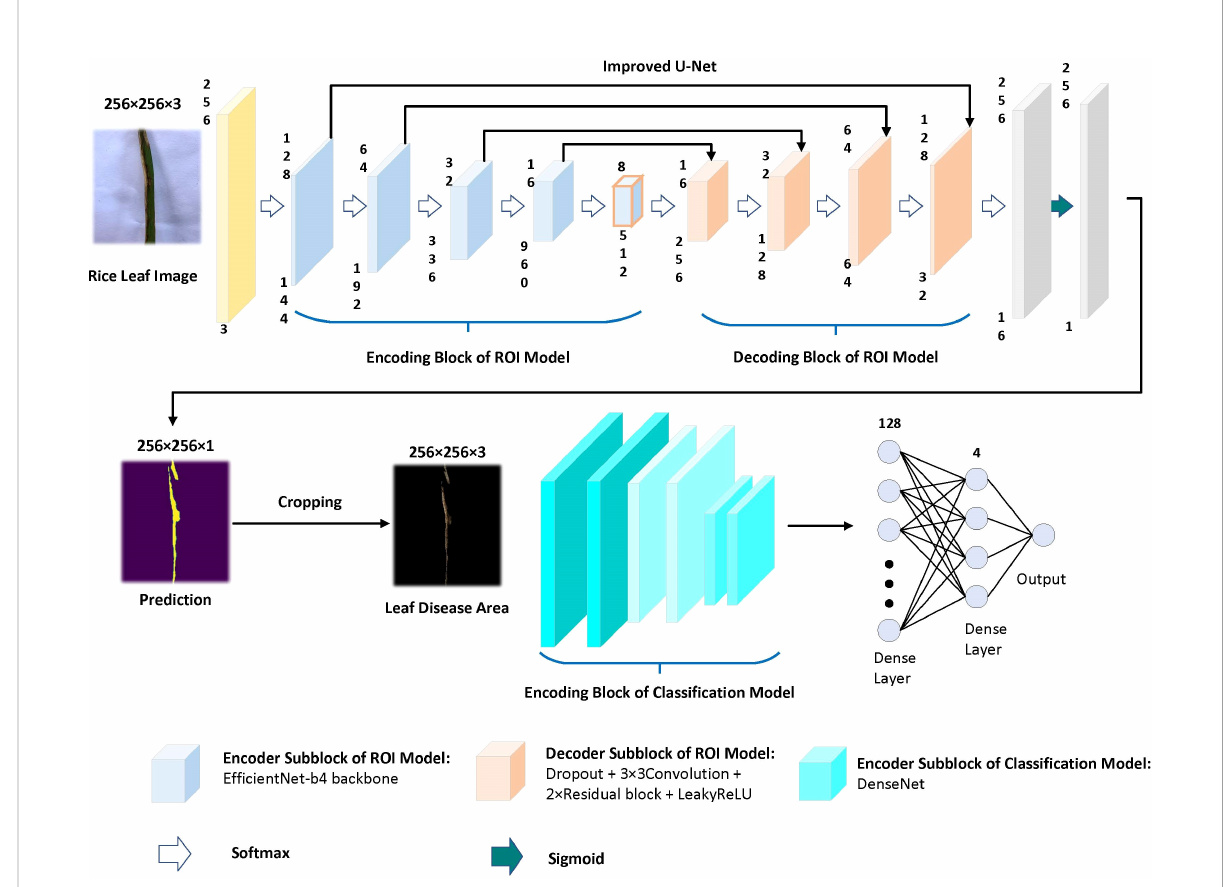
FIGURE 5 Overview of the recognition model. The upper part is the ROI extraction model, and the lower part is the DenseNet classi fi cation